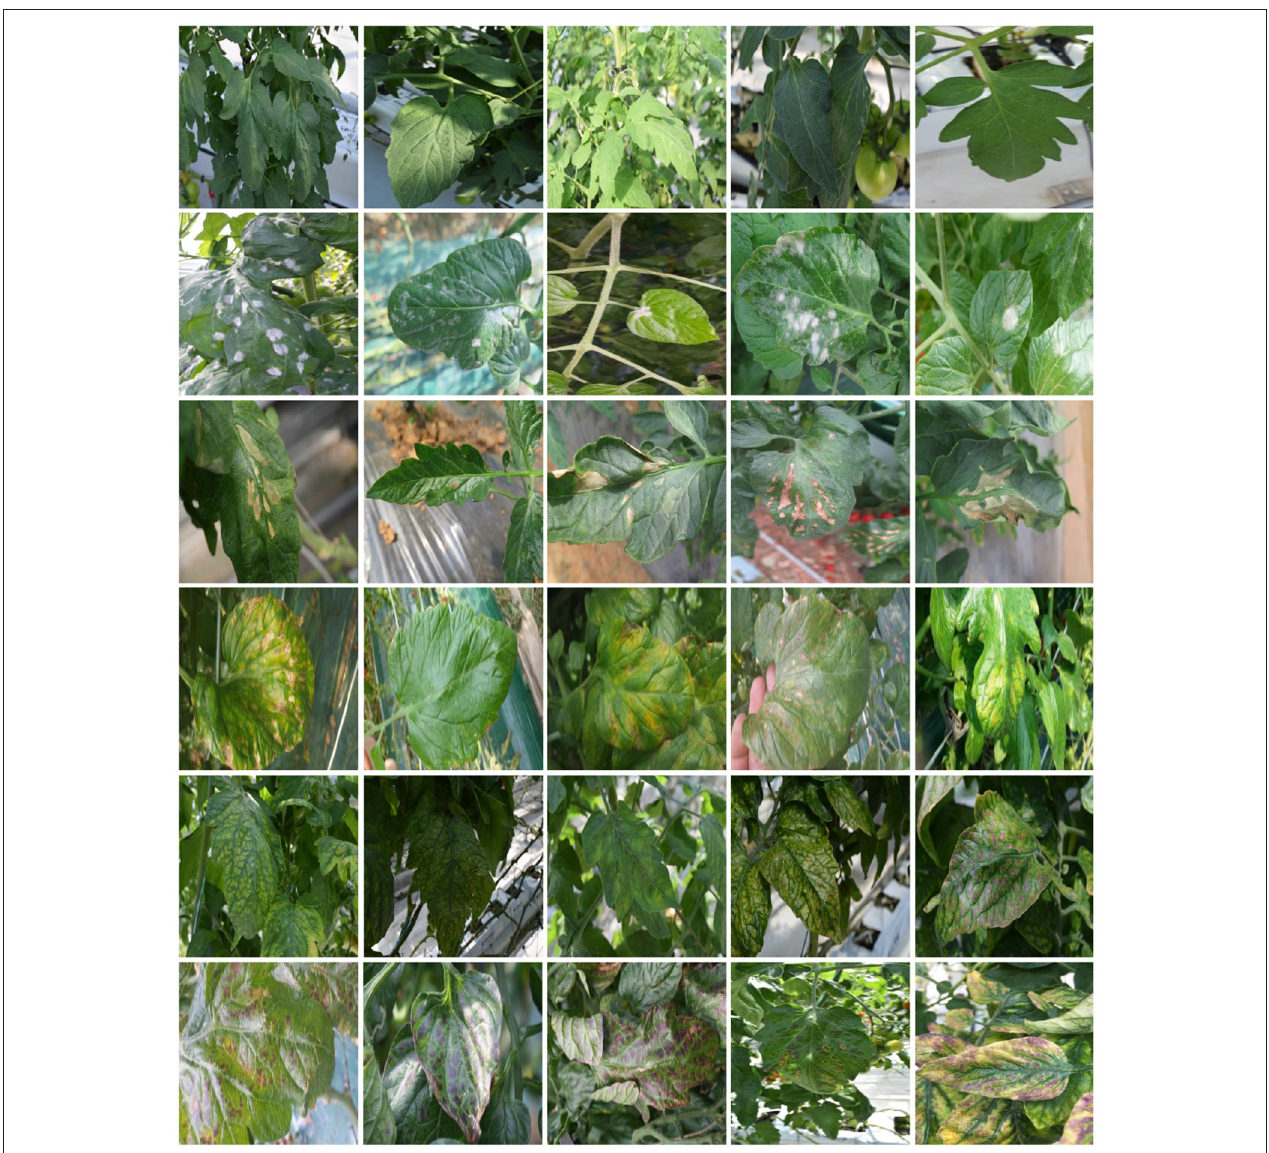
FIGURE 3 | Original tomato leaf dataset. From the first to the last row are Healthy, Powdery (powdery mildew), Canker, LMold (leaf mold), ToCV, MagDef (magnesium deficiency). We collect the dataset from different farms at different times. The variations among the dataset include background, type of tomato, the severity of disease, illumination condition, the distance between the camera and interesting leaf, viewpoint to take the